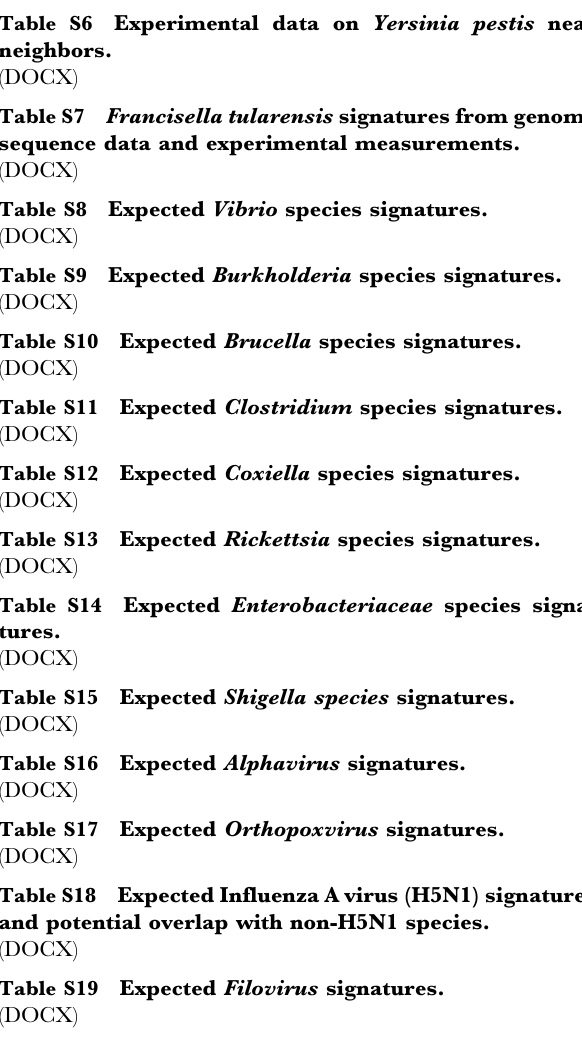
Figure S1 Biothreat assay plate layout. Left panel: Sample wells and target biothreat cluster for each primer pair are indicated. Each well contains two or three multiplexed primer pairs. Letters A through H represent 8 rows of a 96-well plate, whereas numbers 1 through 12 represent the columns. Each sample is analyzed in 16 PCR reaction wells and six samples can be tested per PCR plate. Details of the primer pairs are given in Table 1. Right panel: The 96-well PCR plate layout. Each PCR well includes a synthetic nucleic acid template that serves as a calibrant. In multiplexed wells, this calibrant provides an amplicon similar to the amplicon expected for the organism shown in red. Figure S2 Example of PLEX-ID summary report. Each biothreat cluster is listed separately. Detection of an organism within a cluster is listed at the species level. If no organism within the cluster is detected, the cluster is marked as ‘‘Not Detected’’. The plasmid markers are listed separately. Figure S3 Example of PLEX-ID detailed report. Base compositions associated with each detection are reported. The markers (pXO1 and pXO2 in this example) are reported independently of the biothreat cluster ( Bacillus in this case). Figure S4 Limits of detection for the biothreat assay. Left panel: Analytical limits of the multiplexed primer pairs using synthetic DNA/RNA constructs. Bottom left panel: Detection of spiked DNA/RNA in AE buffer. Bottom right panel: Detection of spiked DNA/RNA in ‘‘Dirty Air’’. The requirement for LOD reporting was detection in all the primer pairs for any given target. Highlighted cells show the concentration at which detection of no more than one replicate was missed. Table S1 USAMRIID B. anthracis strains used in the study. Table S2 Base composition signatures for Keim Genet- ics Lab Bacillus collection. The signatures that are bolded or italicized indicate a SNP variation compared to the predominant signature.